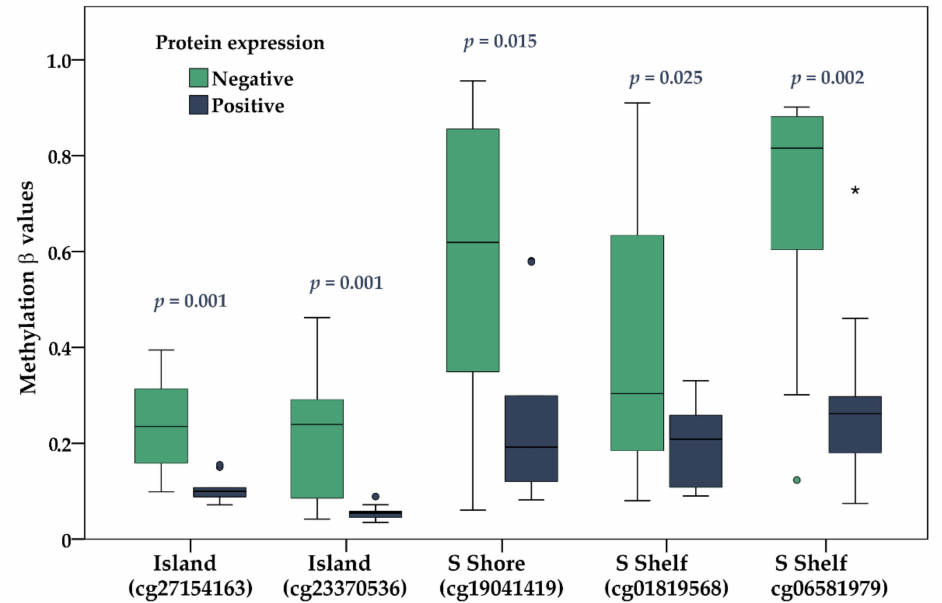
Figure 8. Methylation β values for five regulatory genomic regions of KIT negative and positive UM tumors. A horizontal line depicts the median. The boxes represent the interquartile range (IQR—values between the 75th and 25th percentiles). Values more than three IQRs are labeled as extremes (*), those between 1.5 IQRs and 3 IQRs as outliers